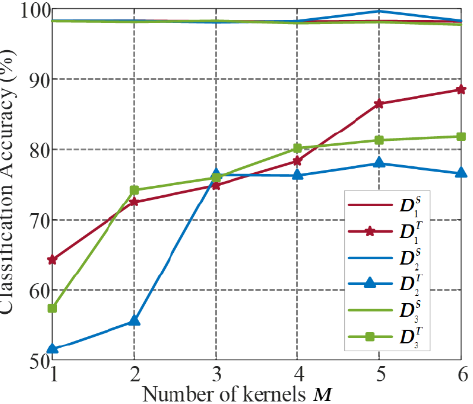
Figure 4. Classification accuracy comparison over different number of kernels. However, monotonic increase in performance stops when M > 5 (tends to be stable on D T in green line, and slightly decline on D T in blue line). Consequently, in comprehen- 3 2 sive consideration of overall performance, M is fixed to be 5 in later experiments unless otherwise